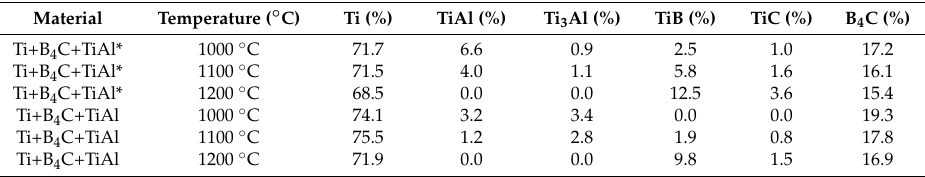
Table 3. Reference Intensity Ratio (RIR) semi-quantification analysis of TMCs manufactured at 80 MPa and at different temperatures (by